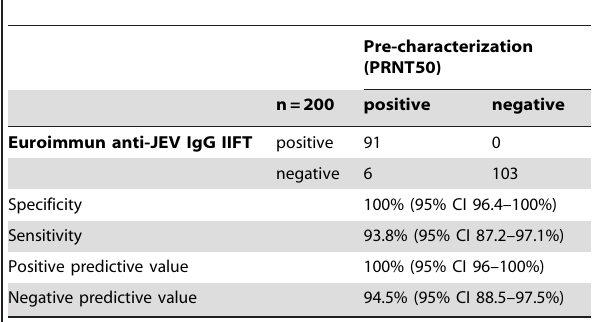
Table 4. Calculated specificity, sensitivity, positive and negative predictive values for the anti-JEV IgG IIFT in comparison to the